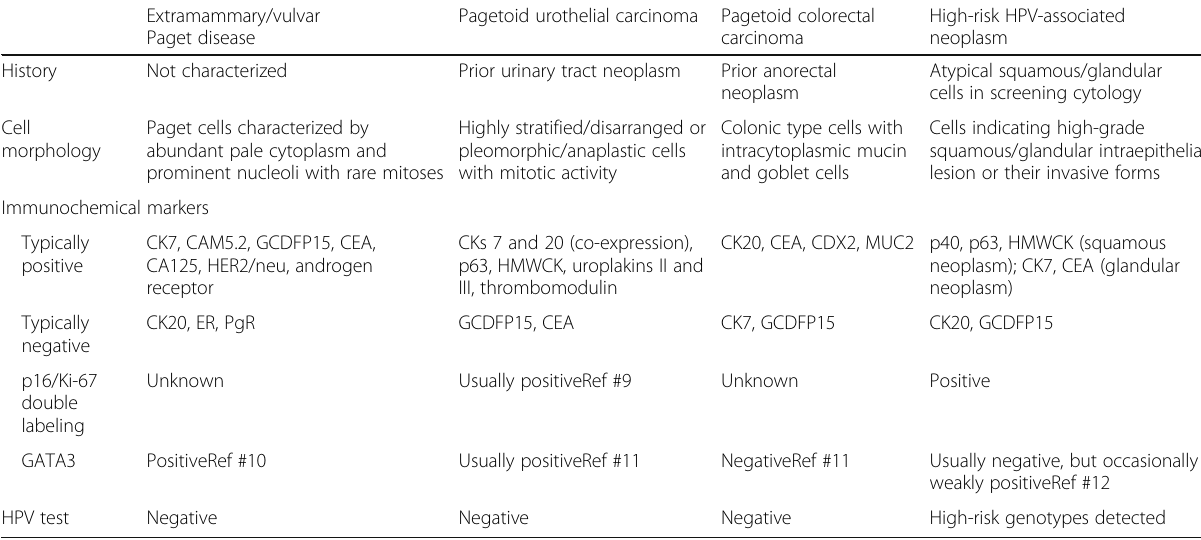
Table 1 Clinicopathologic and laboratory differences between Paget-like neoplasms and mimics of the lower genital tract Extramammary/vulvar Pagetoid urothelial carcinoma Pagetoid colorectal Paget disease carcinoma